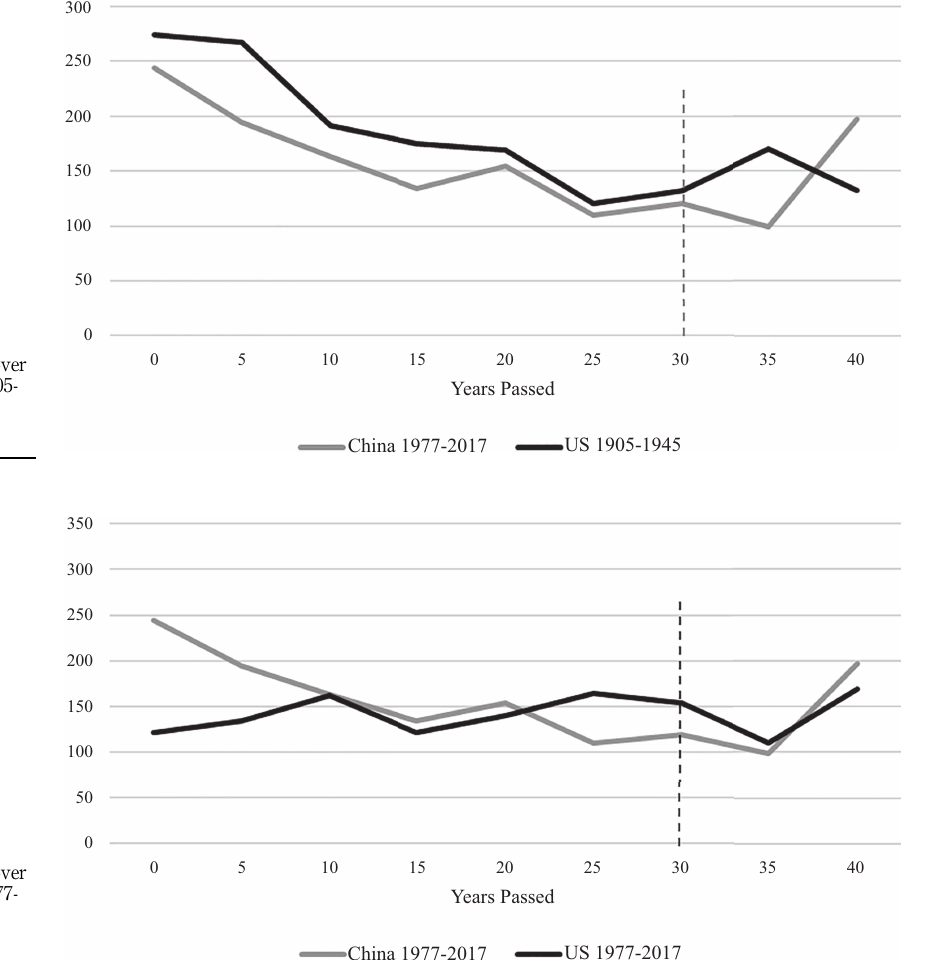
Figure 8. National identity